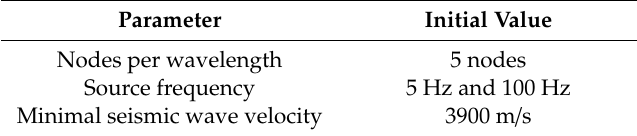
Table 1. The values of the parameters used in the memory requirements calculations.